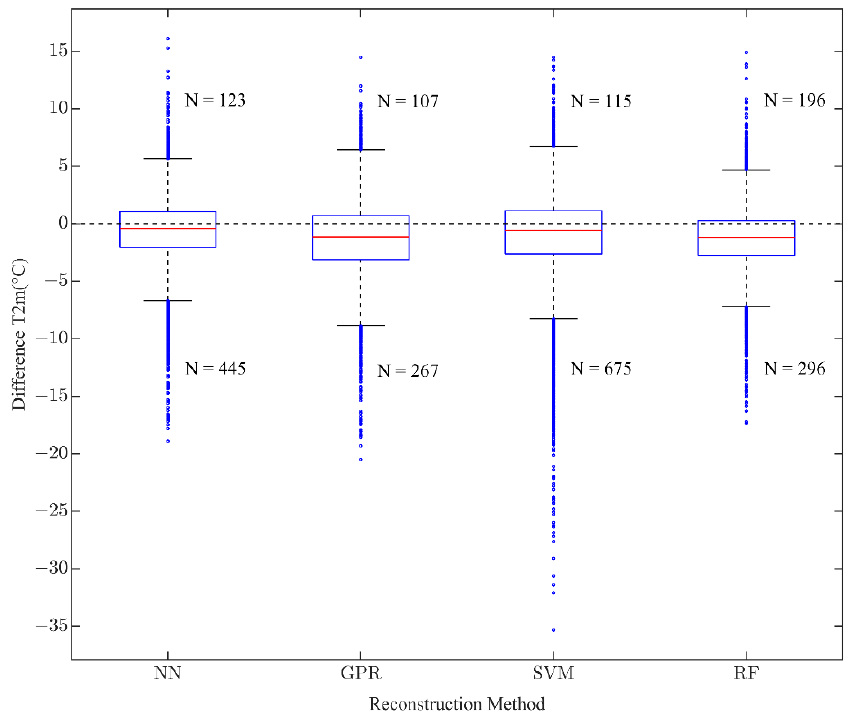
Figure 6. Difference between reconstruction results and observed data at AWSs. The red horizontal line in the rectangular box indicates the median; the closer it is to 0 °C, the more accurate the reconstruction results. The upper end of the box represents the quartile data (i.e., the first 25% of the data). The lower end of the box represents three-quarters of the data (i.e., the first 75% of the data). The upper black horizontal line indicates the upper edge of the data, and the lower black horizontal line indicates the lower edge of the data. The combination of the upper and lower edges indicates the normal distribution range for this data set. The blue dots indicate outliers, and N represents the number of outliers.